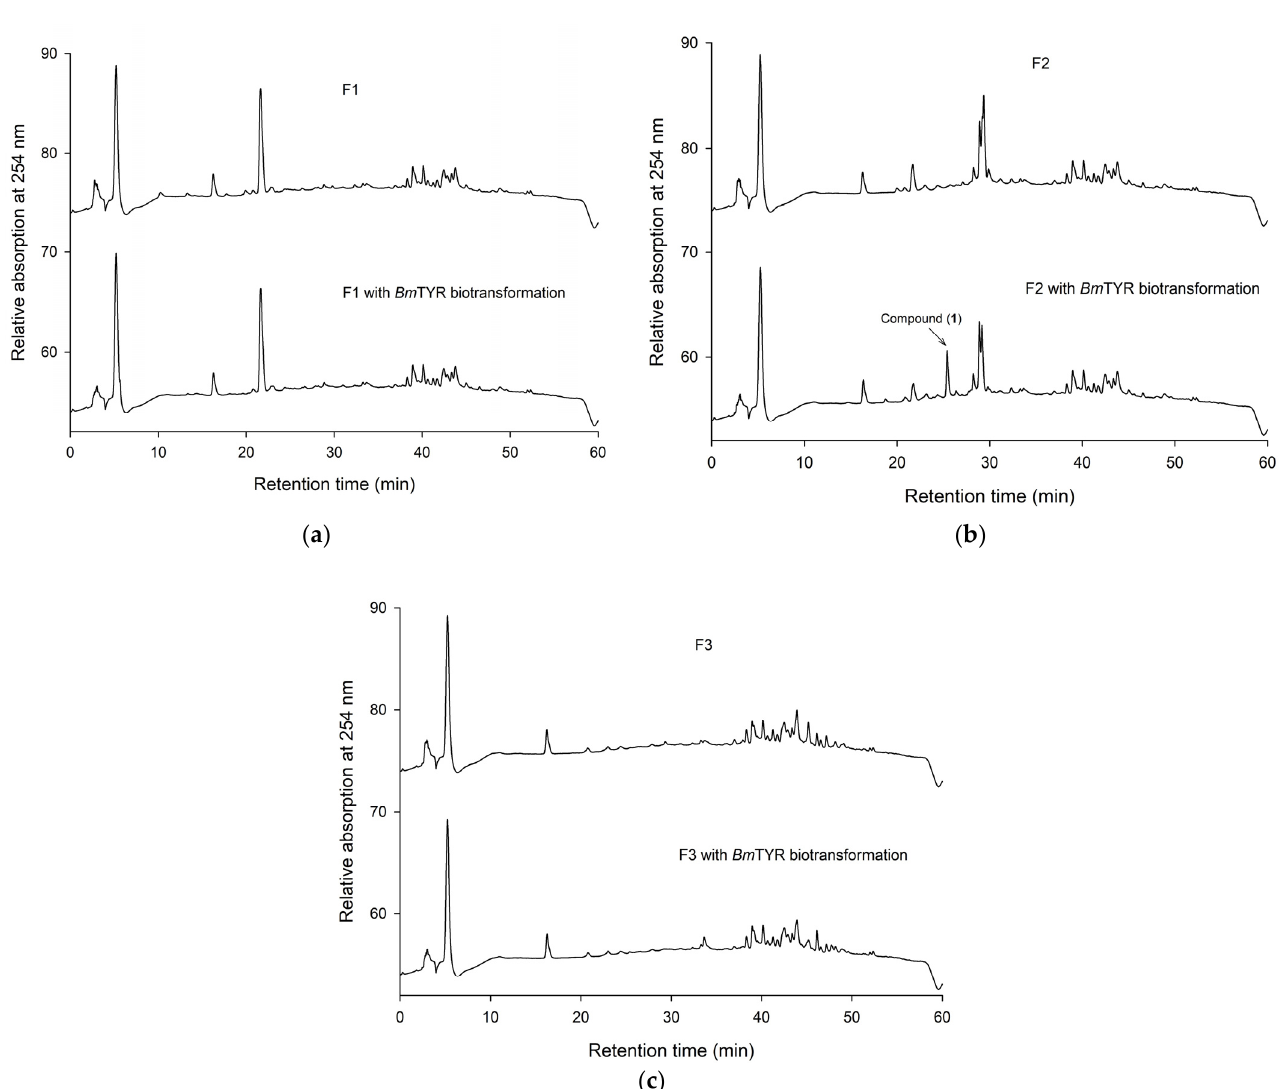
Figure 3. High-performance liquid chromatography (HPLC) analysis of the products biotransformed from F1 ( a ), F2 ( b ), and F3 ( c ) extracts using Bm TYR. The biotransformation and HPLC conditions were the same as those in Figure 2, except that the enzyme substrate (fraction extracts) is replaced with the indicated fractionation extract.